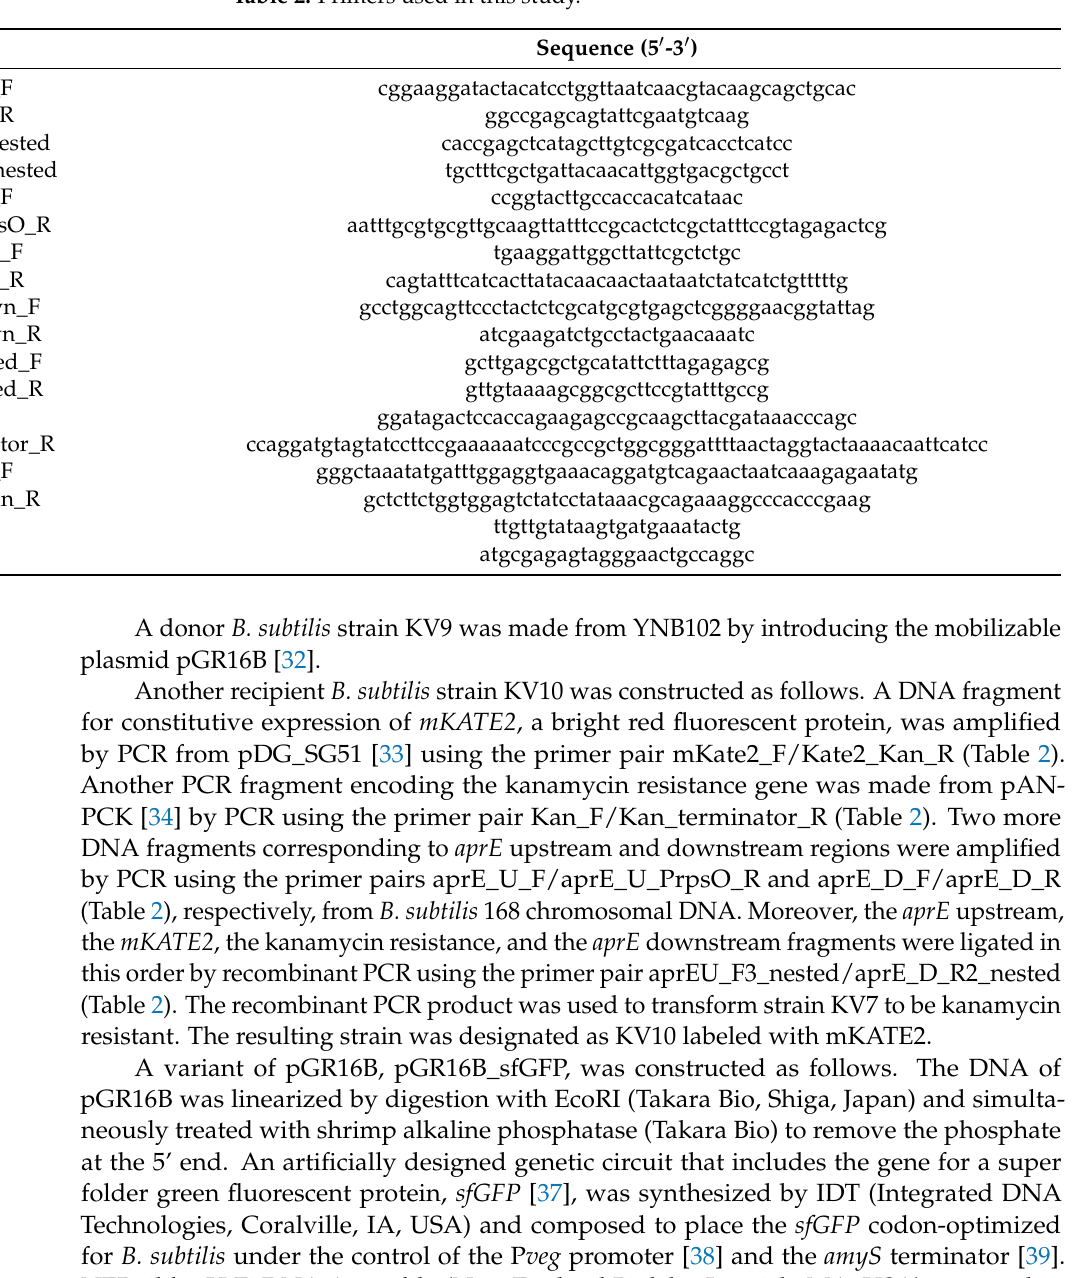
Table 2. Primers used in this